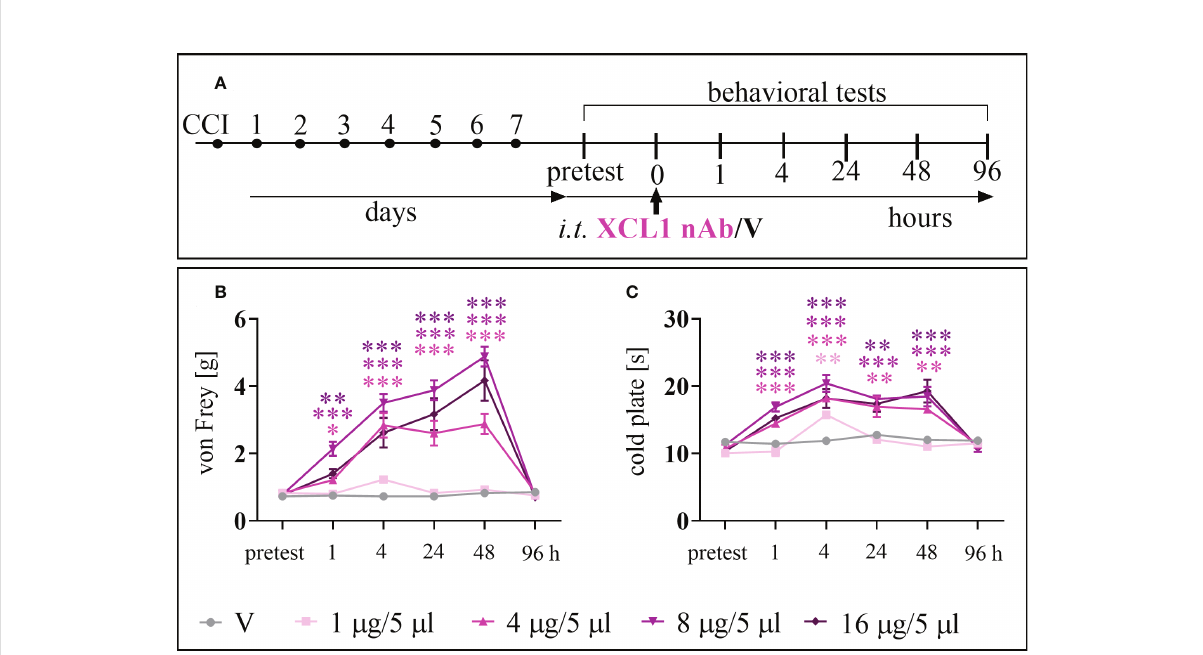
FIGURE 2 The effects of chemokine-C-motif ligand 1 (XCL1) neutralizing antibody (nAb) administered according to scheme (A) , at a dose of 1, 4, 8, or 16 m g/5 m l, on mechanical (B) and thermal (C) hypersensitivity 7 days after chronic constriction injury (CCI) of the sciatic nerve in mice. The data